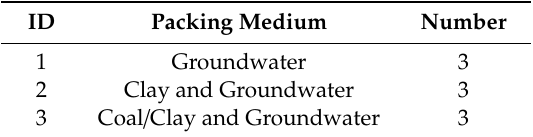
Table 3. The long-term cable-bolt coupon testing